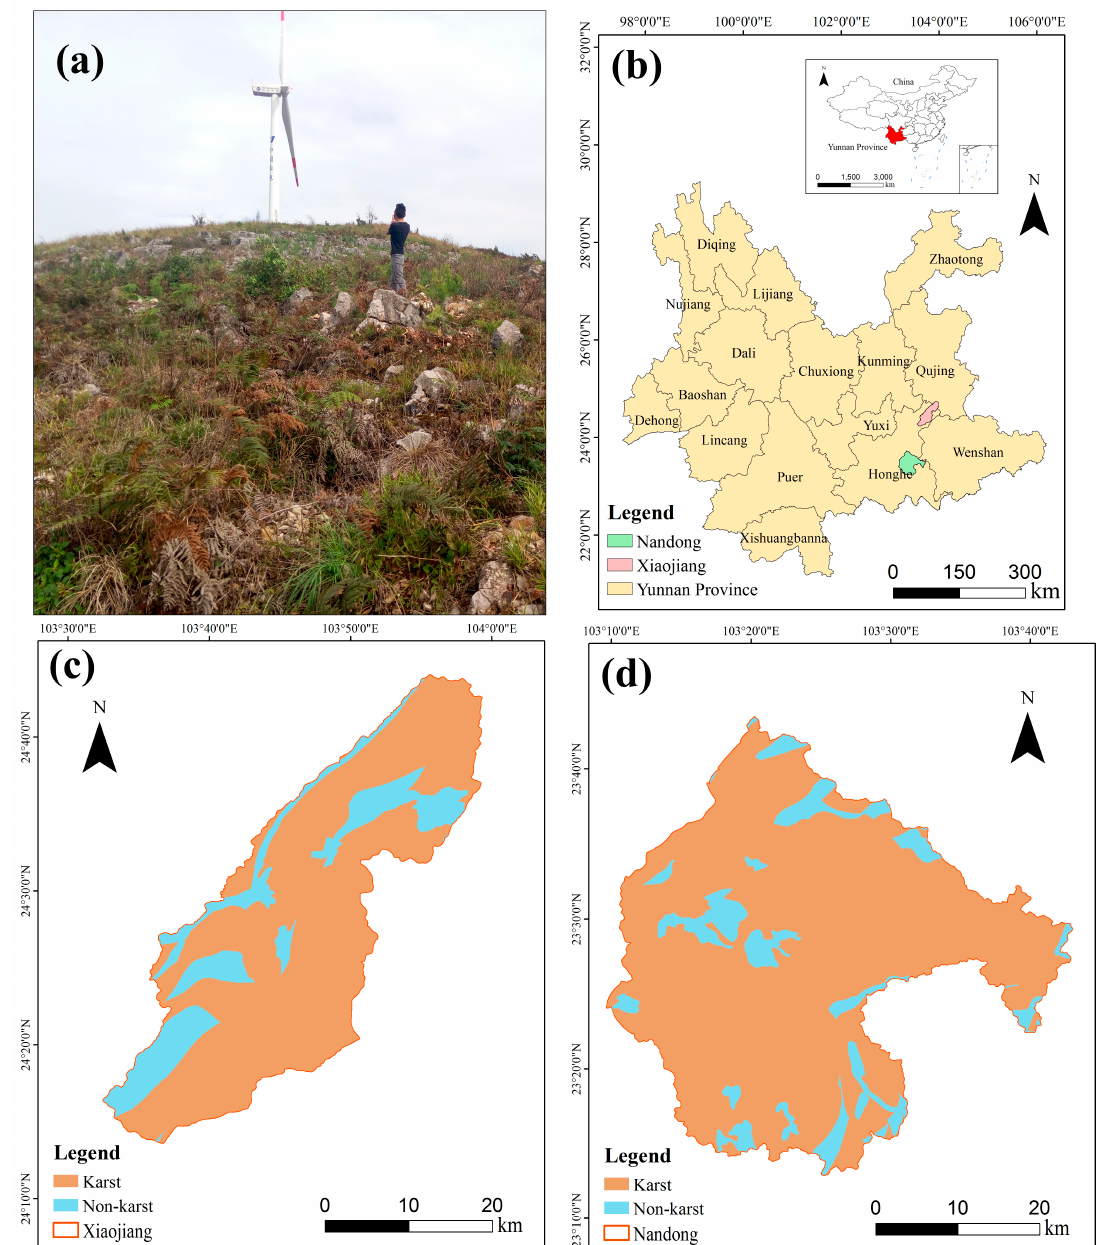
Figure 1. ( a ) Typical karst rocky desertification landscape in southwest China (photo taken during field surveys in January 2017, Pei). ( b ) The location of Yunnan Province in China, Xiaojiang watershed, and Nandong watershed in Yunnan Province. The geological backgrounds of the ( c ) Xiaojiang watershed and ( d ) Nandong watershed.